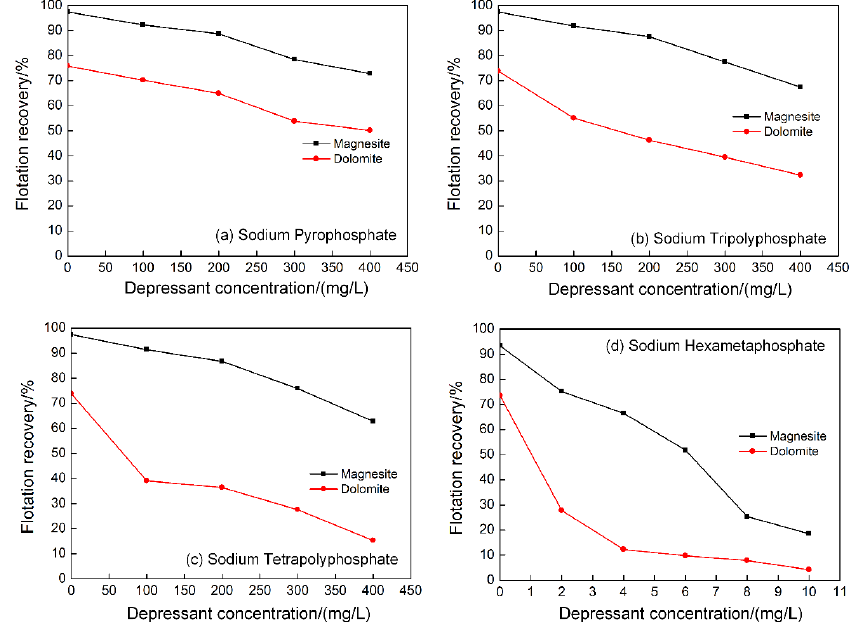
Figure 5. The influence of the concentration of phosphate with different chain lengths on the recovery of mineral flotation. Sodium Oleate 3 × 10 − 4 mol / L. ( a ) Sodium Pyrophosphate, ( b ) Sodium recovery of mineral flotation. Sodium Oleate 3 × 10 –4 mol/L. ( a ) Sodium Pyrophosphate, ( b ) Sodium Tripolyphosphate, ( c ) Sodium Tetrapolyphosphate, ( d ) Sodium Tripolyphosphate, ( c ) Sodium Tetrapolyphosphate, ( d ) Sodium Hexametaphosphate.